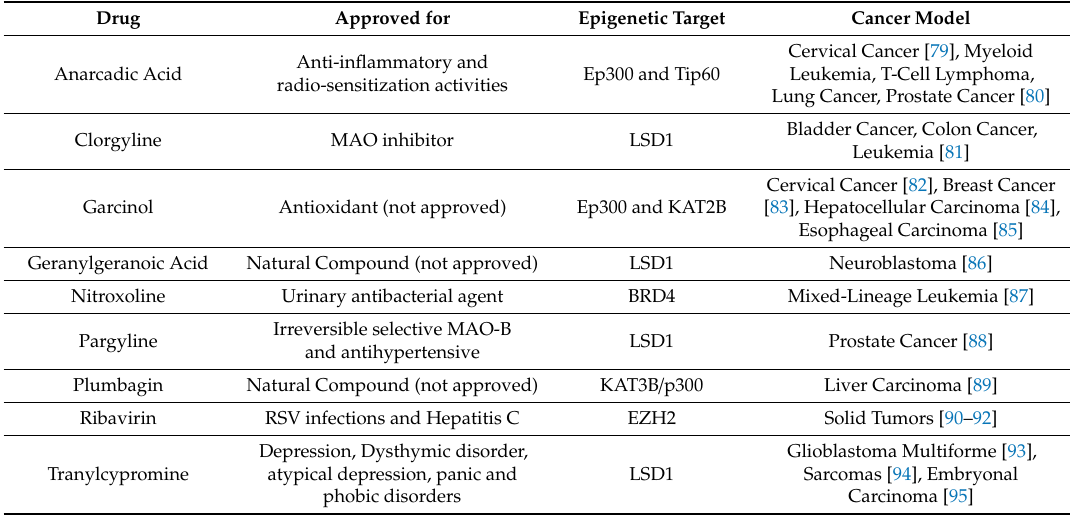
Table 3. Noncancer drug repurposing candidates for HAT, HMT, HDM and BET inhibition.